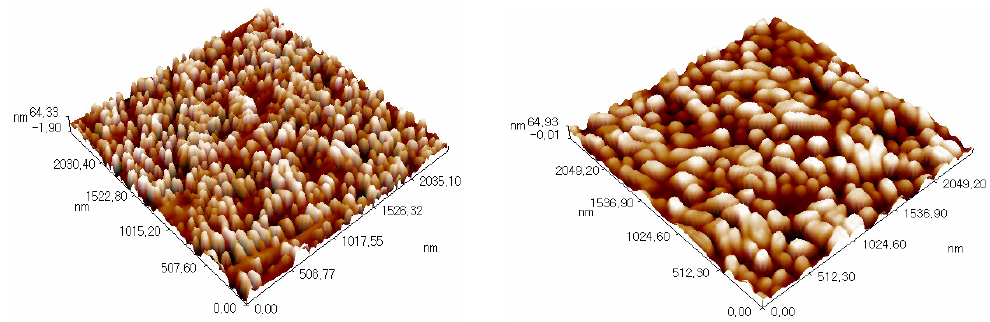
Fig. 8. 2D and 3D images of (a) polished, (b)corroded, (c) inhibited sample with 175ppm of drug and (d) inhibited sample with 225ppm of drug.